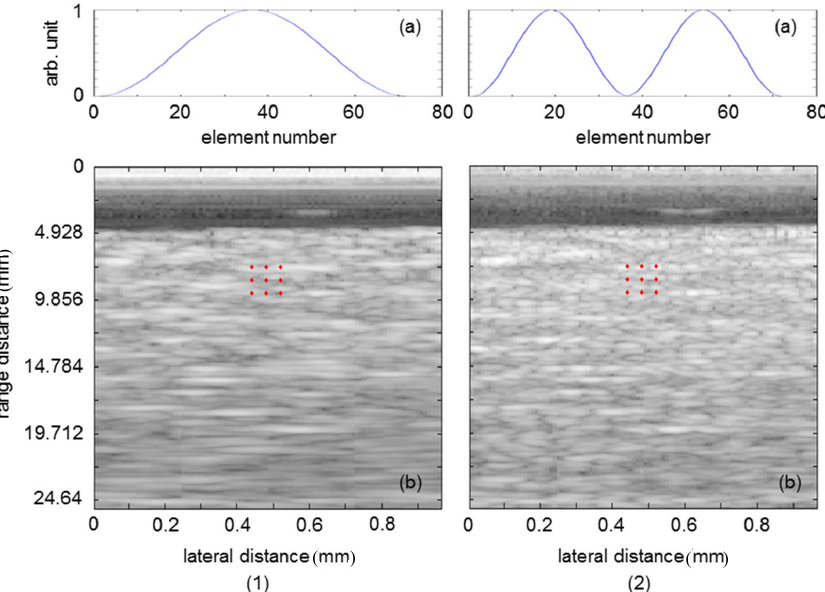
Figure 7. B-mode images of phantom obtained with ( 1 ) Hanning apodization and ( 2 ) lateral modulation [31]. ( a ) Receive apodization. ( b ) B-mode image.